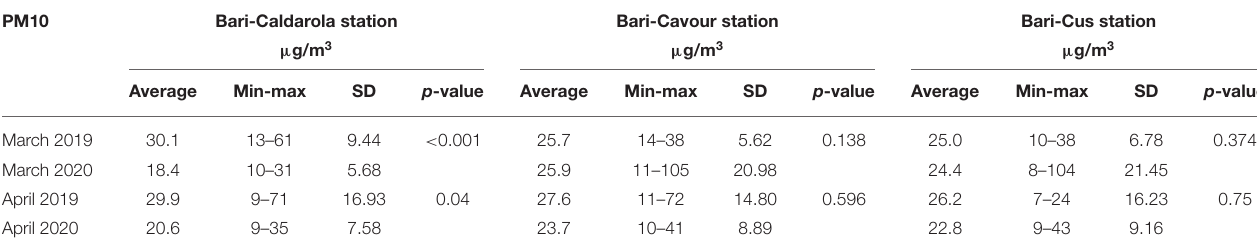
TABLE 2 | PM10 March-April 2019/2020 concentrations.